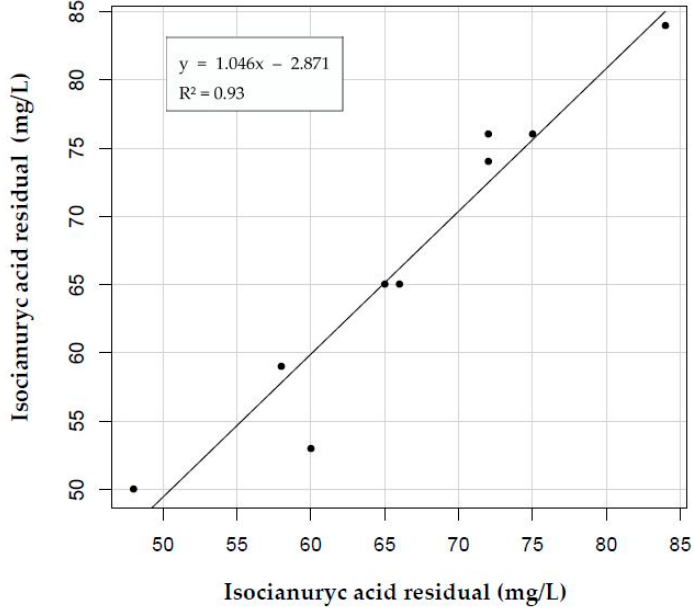
Figure 3. Linear correlation of the two methods studied.